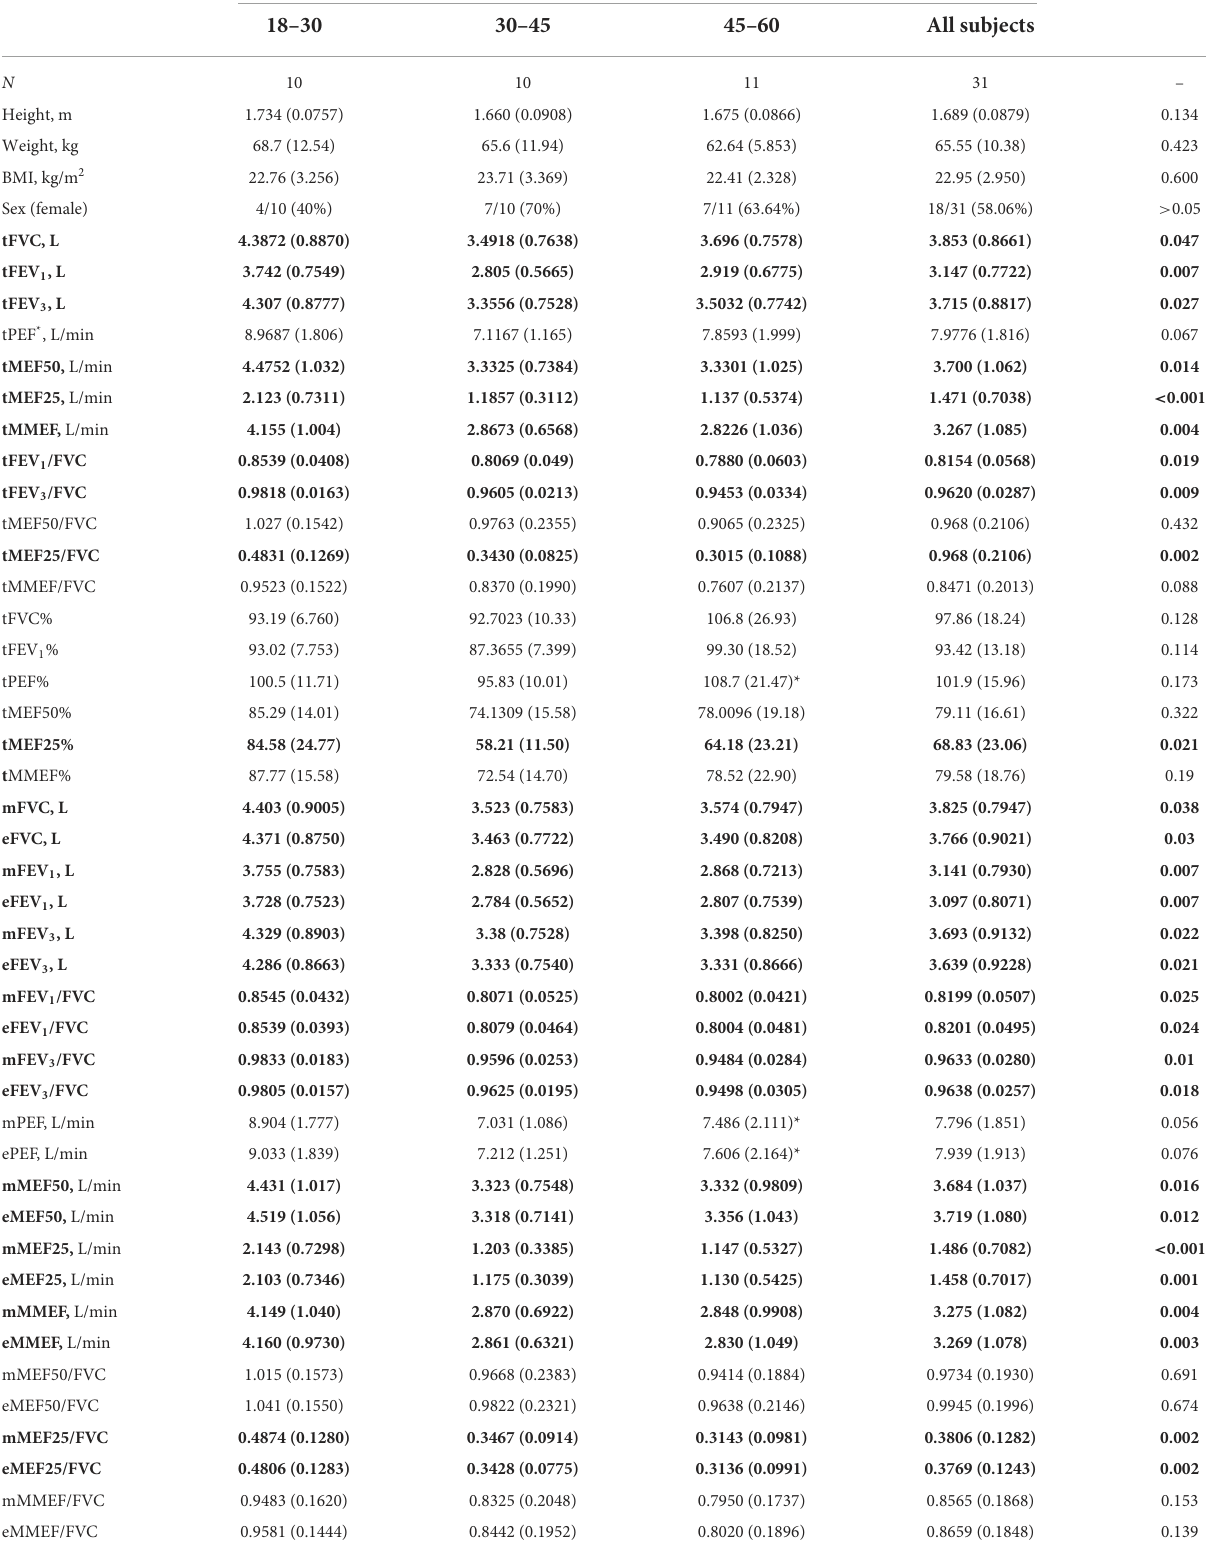
TABLE 2 Portable spirometry variable values according to